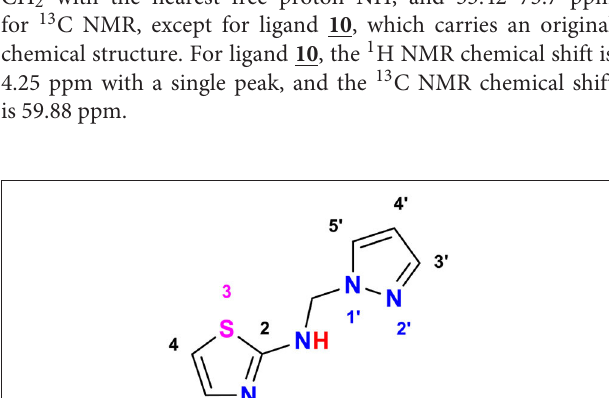
To formulate this compound, 1.5 g of 2-aminothiazole